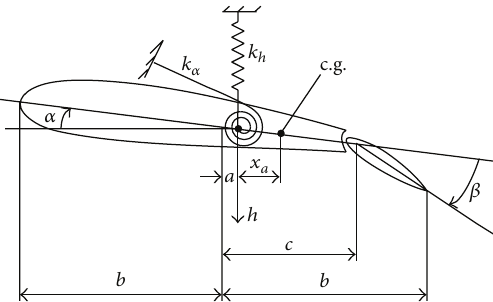
Figure 1: Schematic of airfoil section with a control surface.